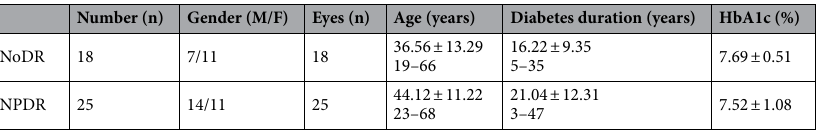
Table 1. Demographics of participants: diabetic patients without diabetic retinopathy (NoDR) and with mild signs of diabetic retinopathy (NPDR).